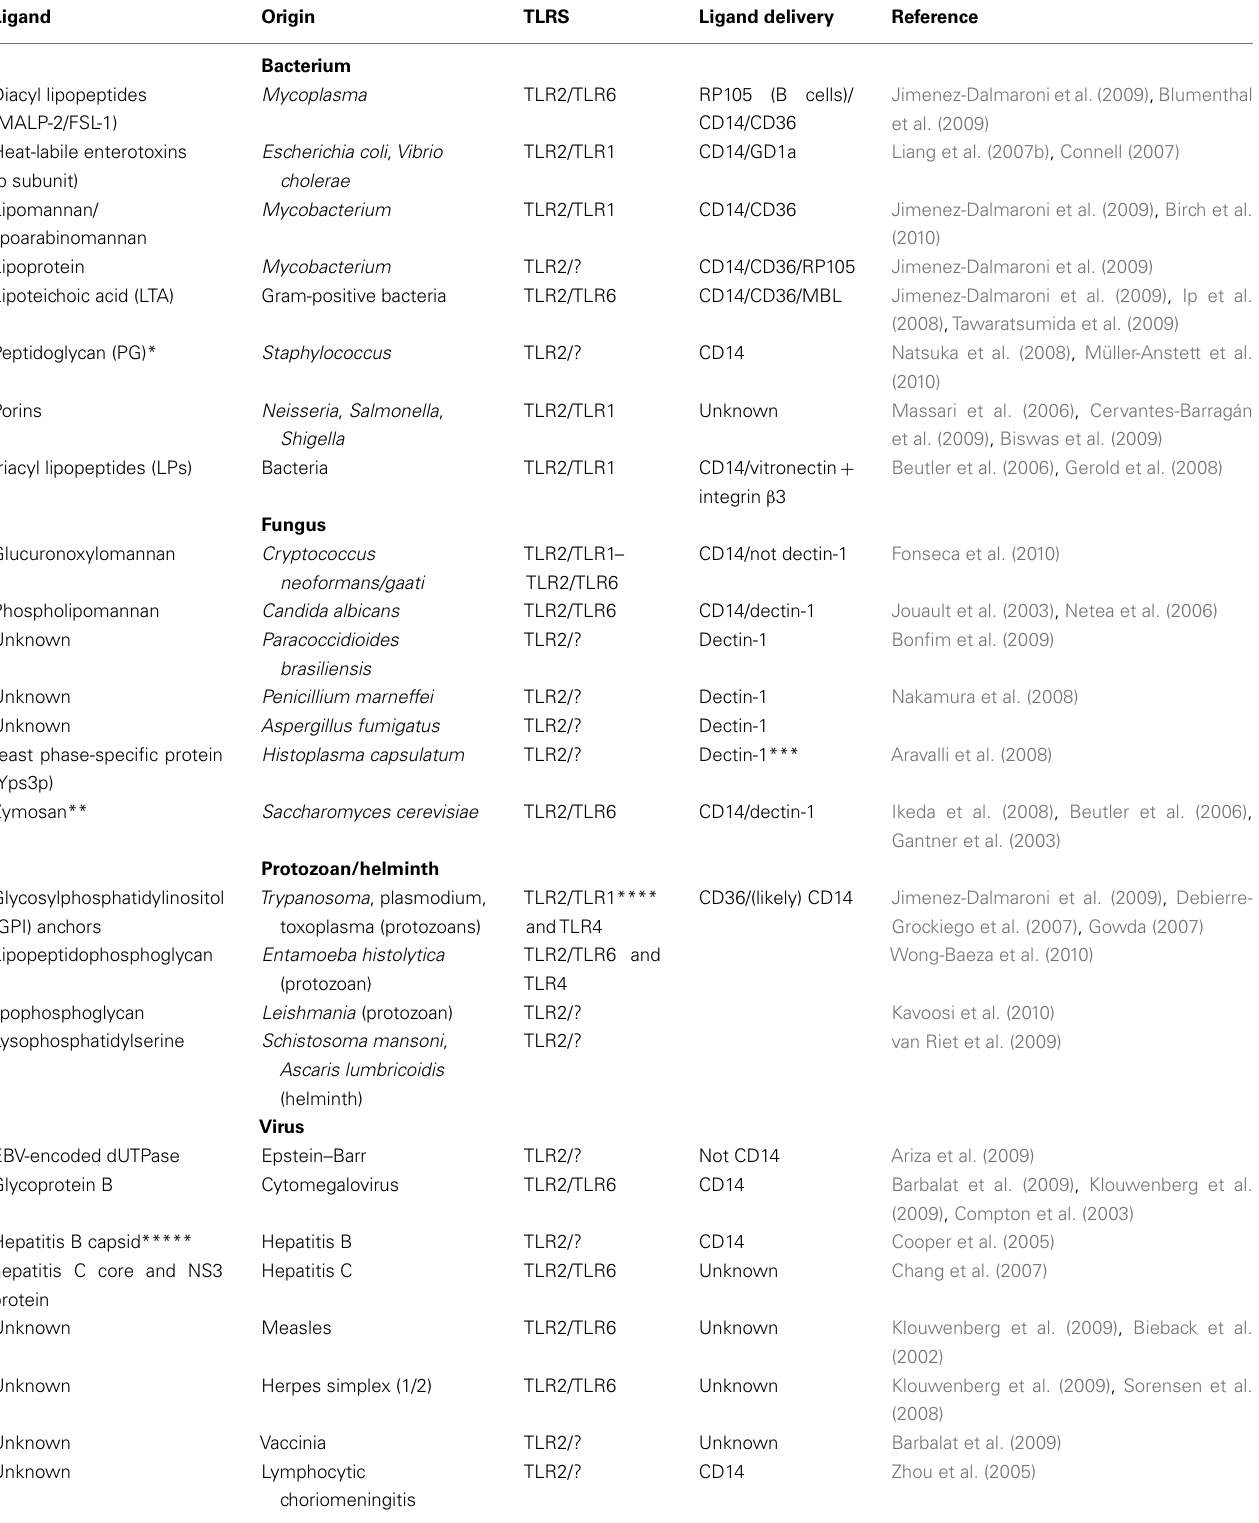
Table 1 |TLR2 microbial